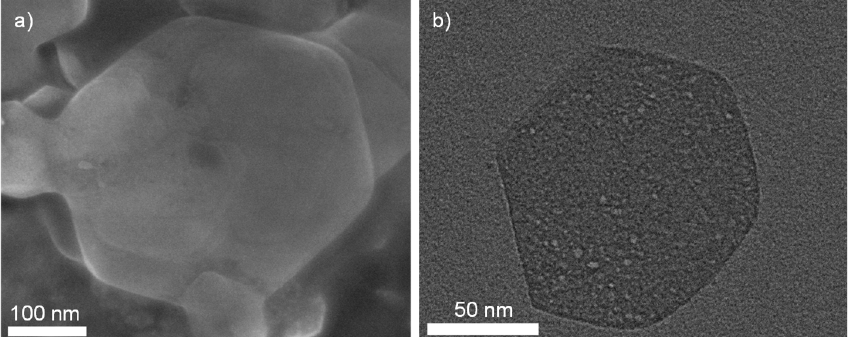
Figure 7. Electron microscope images of typical crystallites of Co 2 Al–NO 3 LDH were taken in scanning mode ( a ) and in scanning transmission mode ( b ).